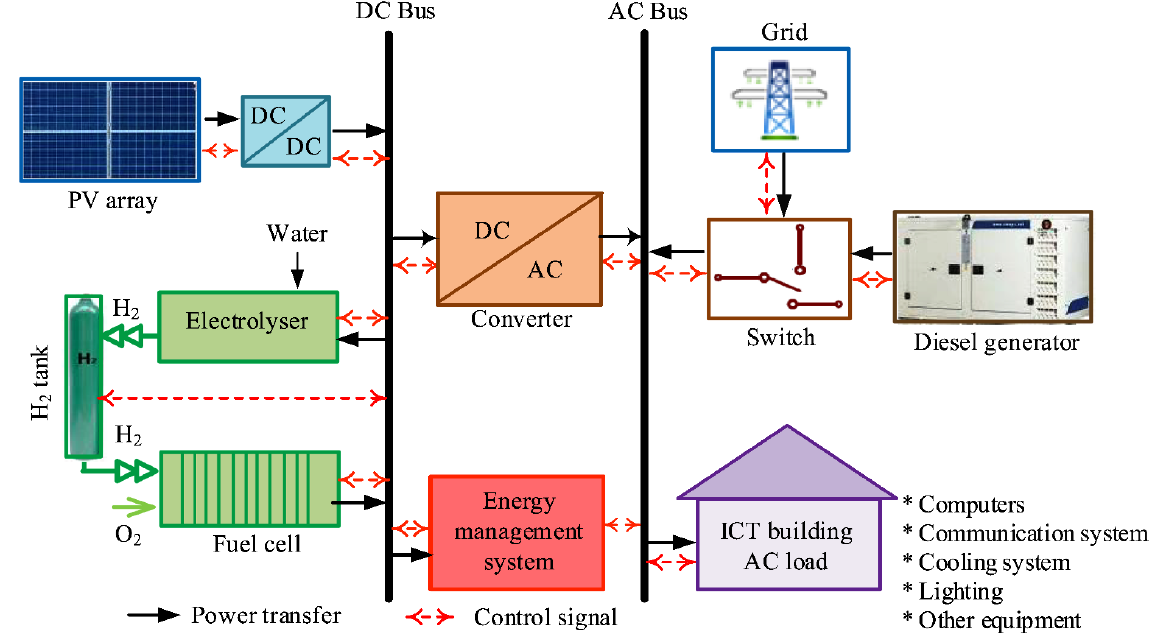
Figure 12. Flow diagram of a grid-connected PV-RHFC nanogrid for application in a university building. Reprinted with permission from Ref. [54]. 2021, Elsevier. Table 3. Nanogrid system applications.